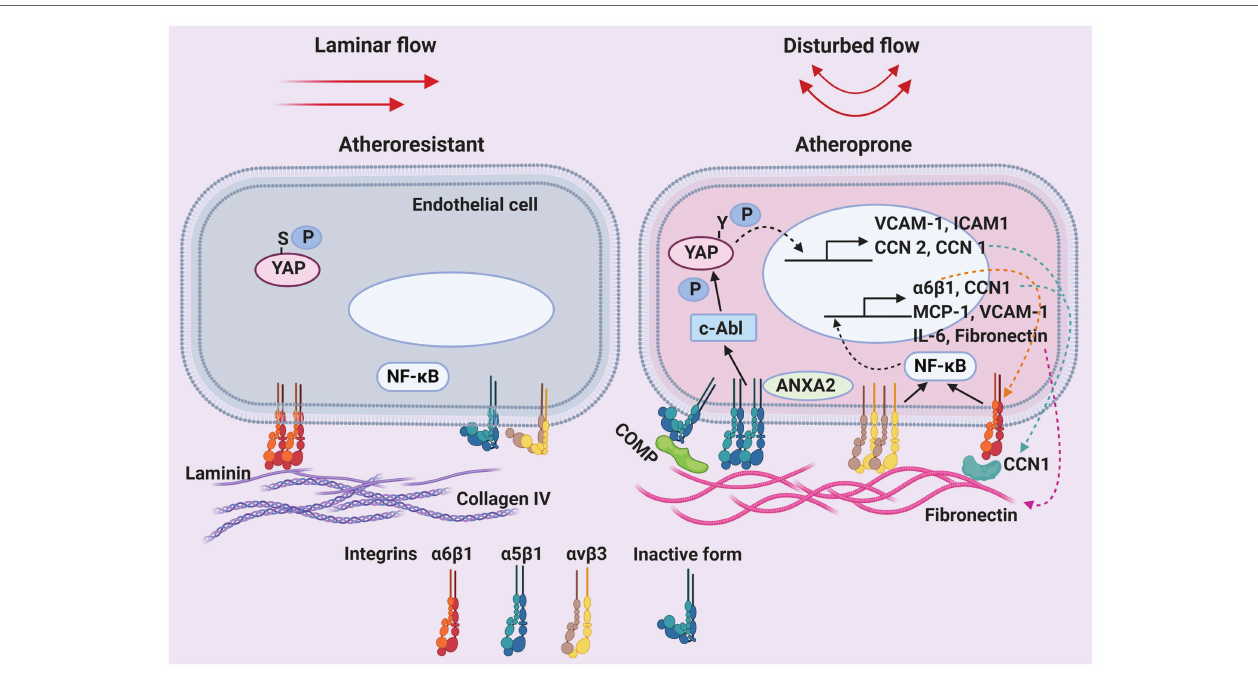
FIGURE 1 | Shear-regulated extracellular microenvironments and endothelial integrin receptors in atherosclerosis. Schematic of the dynamic changes in the composition of the endothelial basement membrane and cell-surface integrin receptors by unidirectional laminar blood flow or oscillatory disturbed flow. Solid arrows: activation of downstream effectors. Dashed arrows: translocation of proteins. ANXA2, annexin A2; COMP, cartilage oligomeric matrix protein; ICAM1, intercellular adhesion molecule 1; IL-6, interleukin-6; MCP-1, monocyte chemoattractant protein 1; NF- κ B, nuclear factor- κ B; P, phosphorylation; S, serine; VCAM-1, vascular cell adhesion molecule 1; Y, tyrosine; YAP, yes-associated